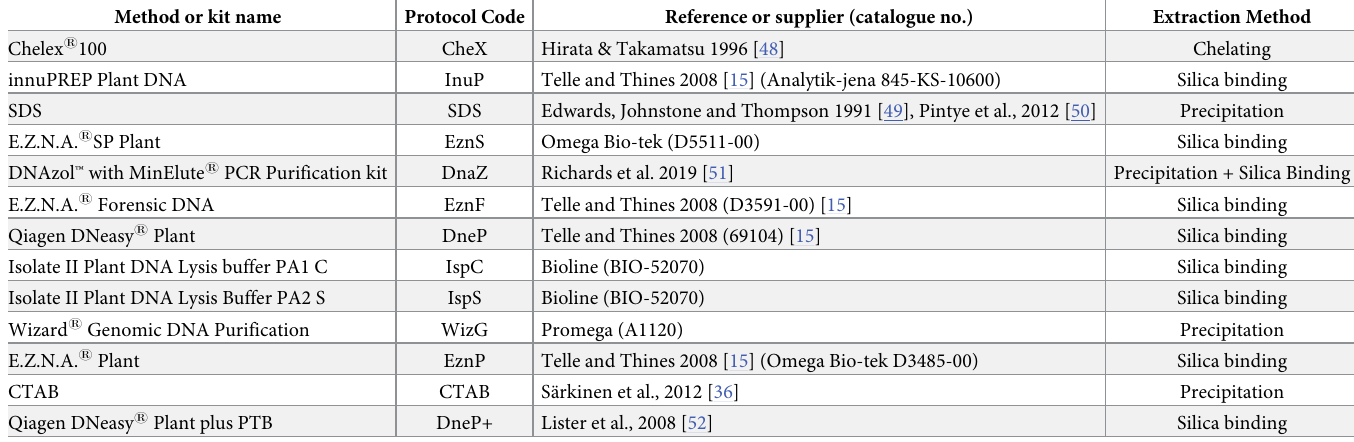
Table 7. DNA extraction protocols tested on five VPRI apple powdery mildew P . leucotricha specimens in this